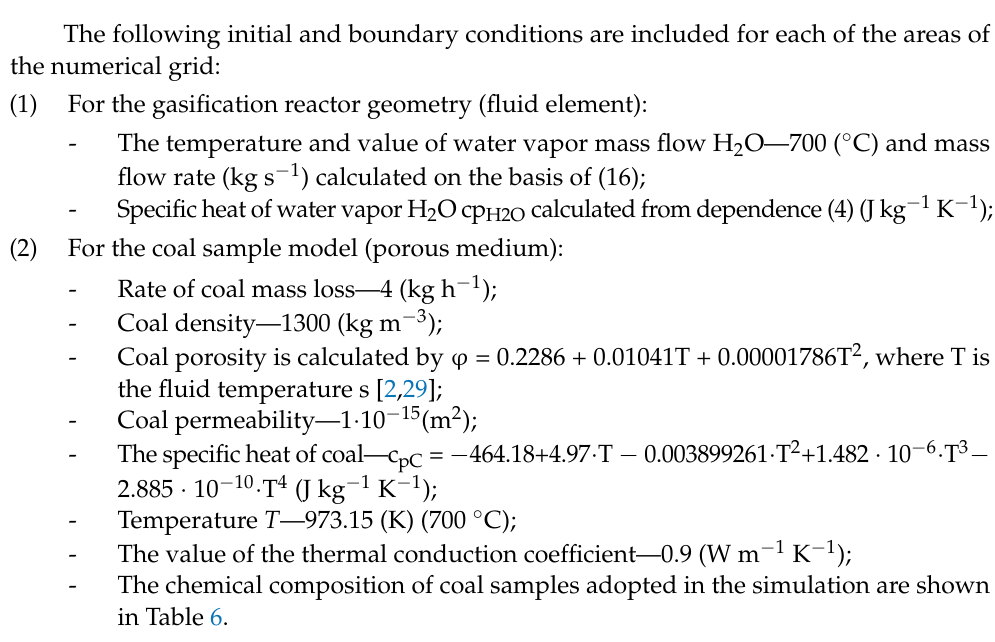
Table 6. Proximate/ultimate analysis of coal adopted in numerical calculations. Hard Coal Mine A Hard Coal Mine B Hard Coal Mine